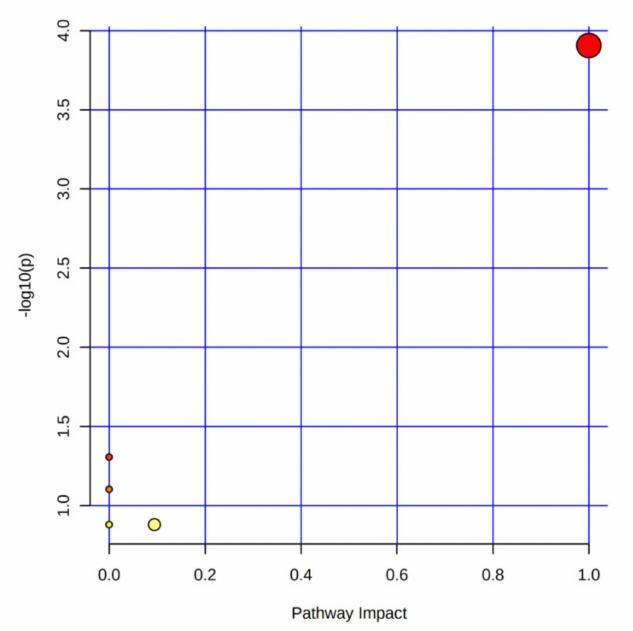
Figure 9. Pathway analysis of the differential